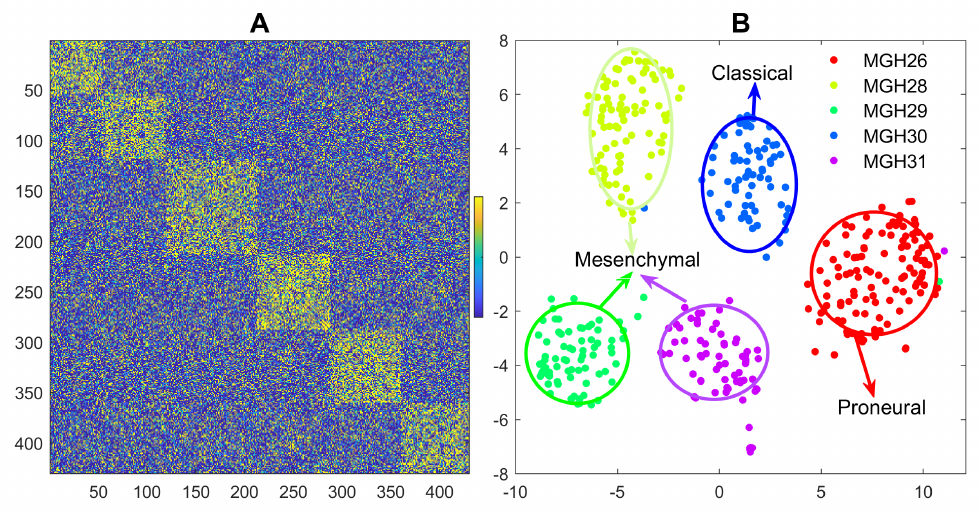
Figure 2. 2D visualization with heatmap and tSNE for the detected clusters of five glioblastomas: ( A ) heatmap with the high-order(partial) correlation matrix from RGGC, where orange dots indicate stronger correlation and the numbers with the x- and y- axis represent the cells. The block diagonal (checkerboard) structure of the heatmap indicates well-clustered cells; ( B ) tSNE visualization, where different colors represent different detected clusters. The five well-separated clusters are in line with the tumor